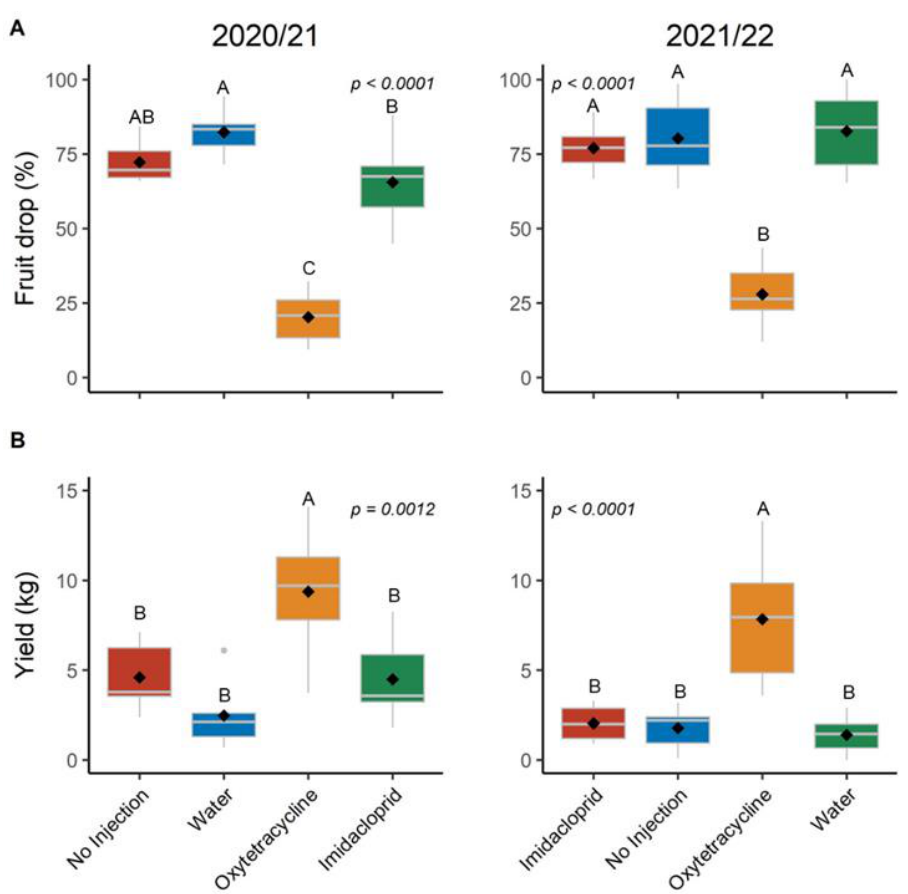
Figure 3. Fruit drop and yield in production seasons 2020/21 and 2021/22. ( A ) cumulative percent preharvest fruit drop calculated as the cumulative number of fallen fruit counted monthly divided by the number of fallen plus harvested fruit; ( B ) fruit yield per tree. Different letters indicate significant differences ( p < 0.05) according to Tukey’s honest significant difference